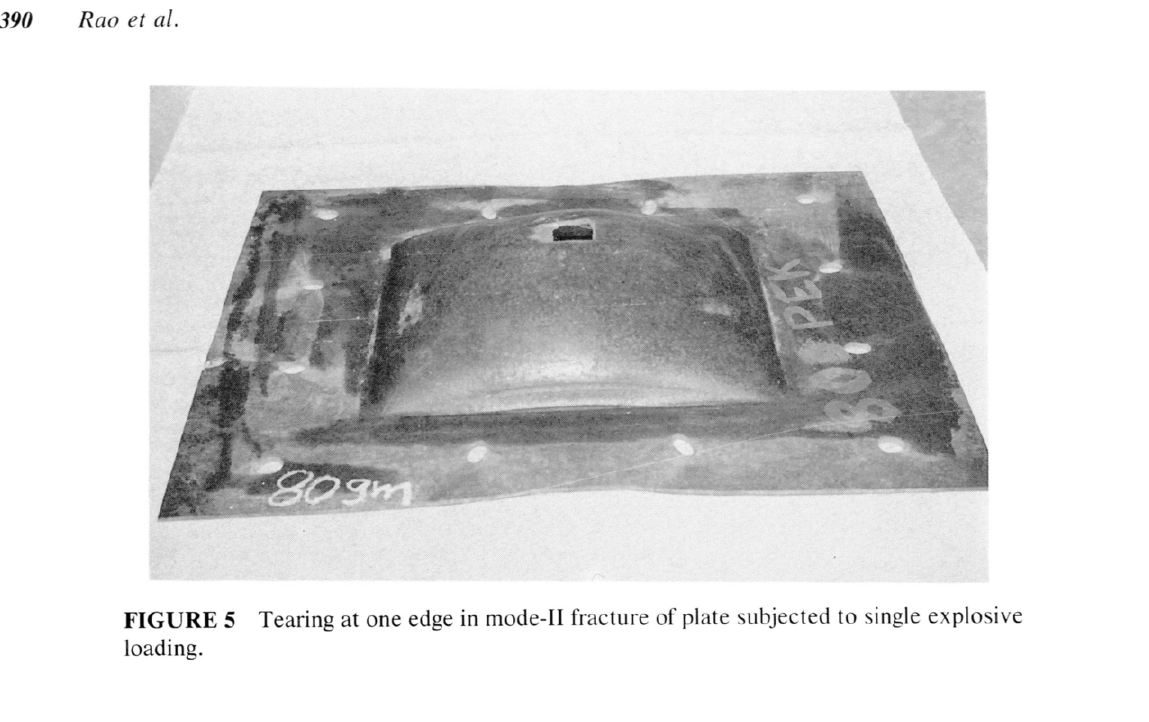
FIGURE 5 Tearing at one edge in mode-II fracture of plate subjected to single explosive loading.